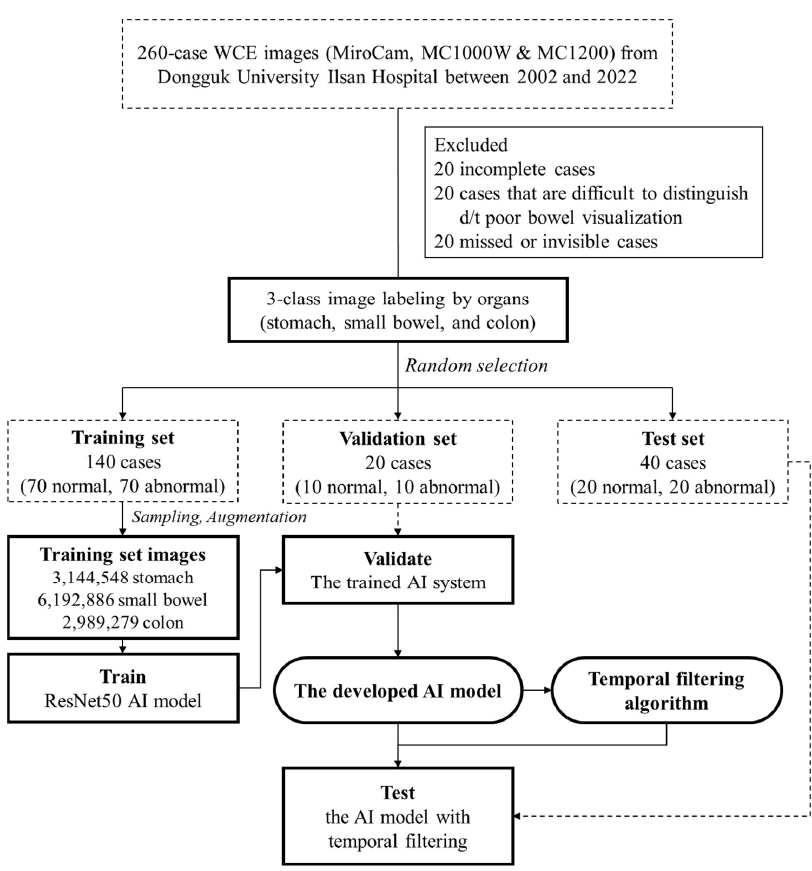
Figure 1. Flowchart of the study design.